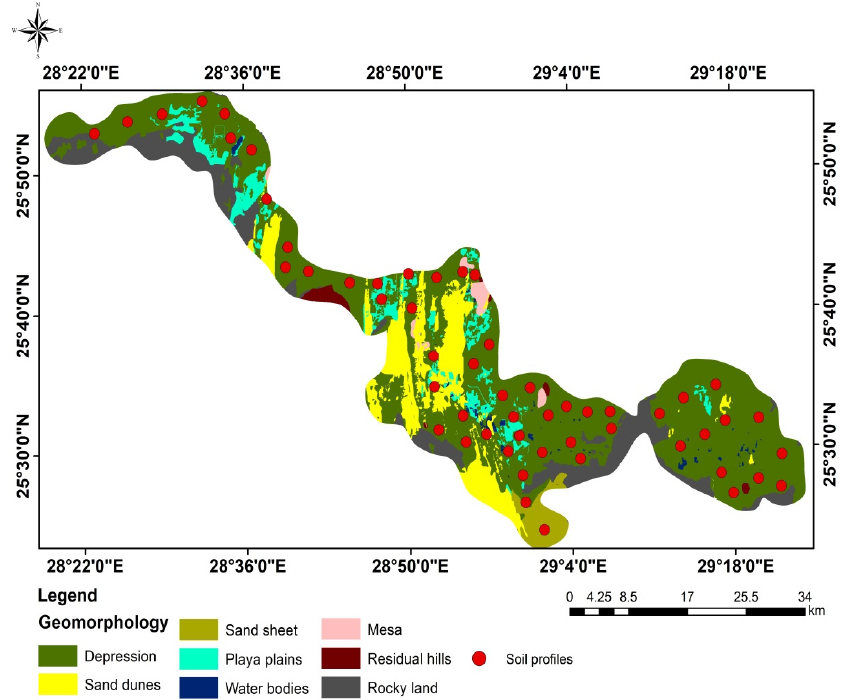
Figure 2. Geomorphological map of the study area and soil sampling site. Table 1. Standard scoring function (SSF) of physicochemical indicators to assess soil quality. Indicator